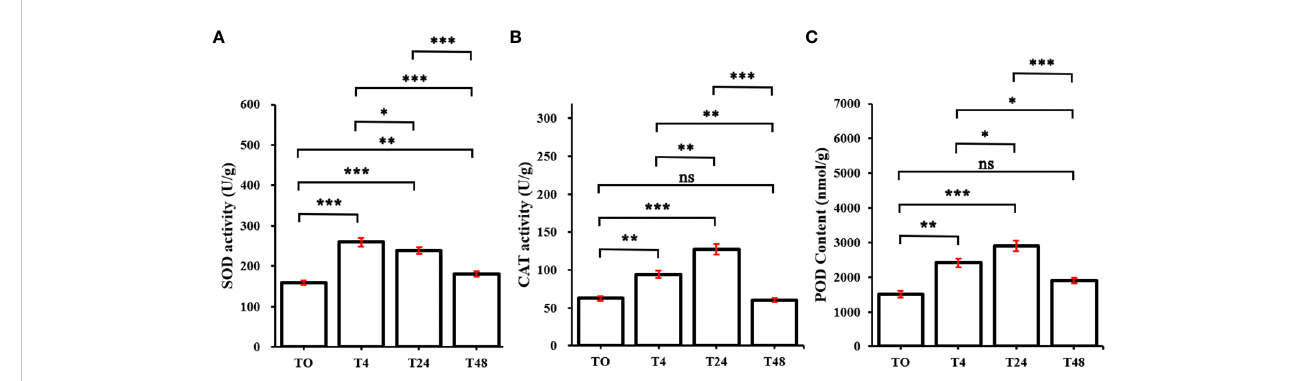
FIGURE 2 Changes of oxidoreductase in M. truncatula under continuous aluminum stress. (A) superoxide dismutase (SOD) activity. (B) Catalase (CAT) activity. (C) peroxidase activity (POD). The plotting data is the average and standard deviation of three repetitions. T0~T48 represent M. truncatula plant samples treated with aluminum for 0h, 4h, 24h, and 48h, respectively. According to Duncan ’ s multiple range test, the asterisk represents the signi fi cant difference between aluminum treated samples and the control (*, P < 0.05; **, P < 0.01; ***, P < 0.001), ns indicates that the difference is not signi fi cant.